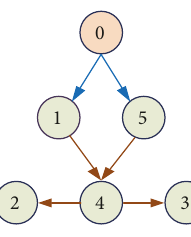
Figure 1: Communication topology